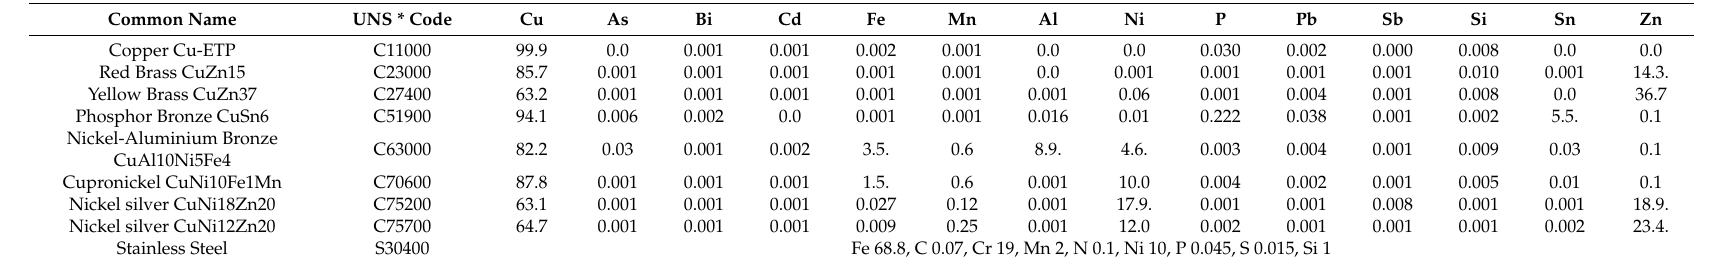
Table 1. Compositions (%) of the tested commercial copper